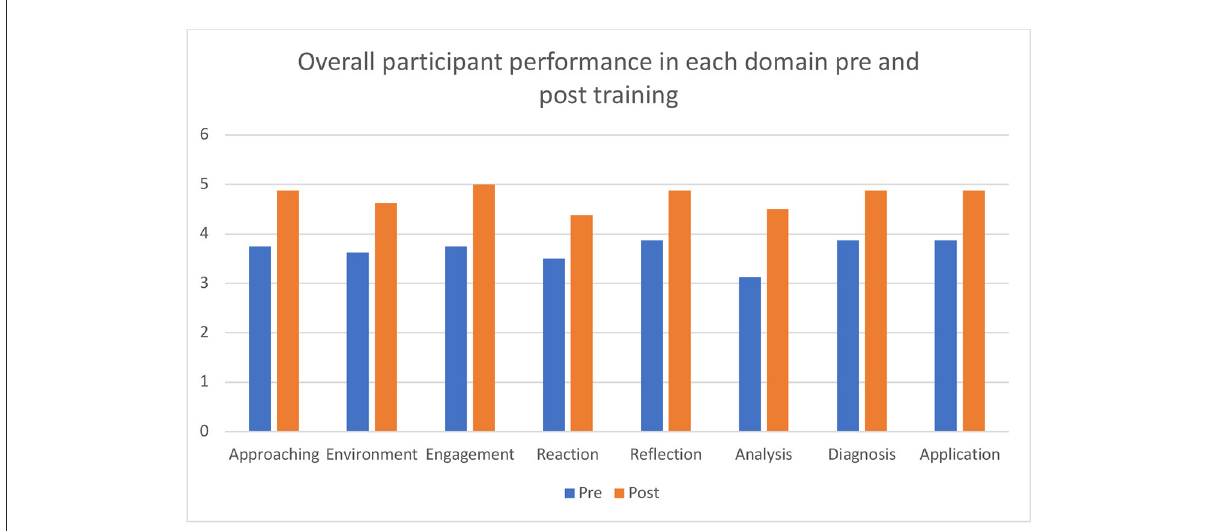
FIGURE1 Average OSAD scores across all domains before and after facilitator debriefing